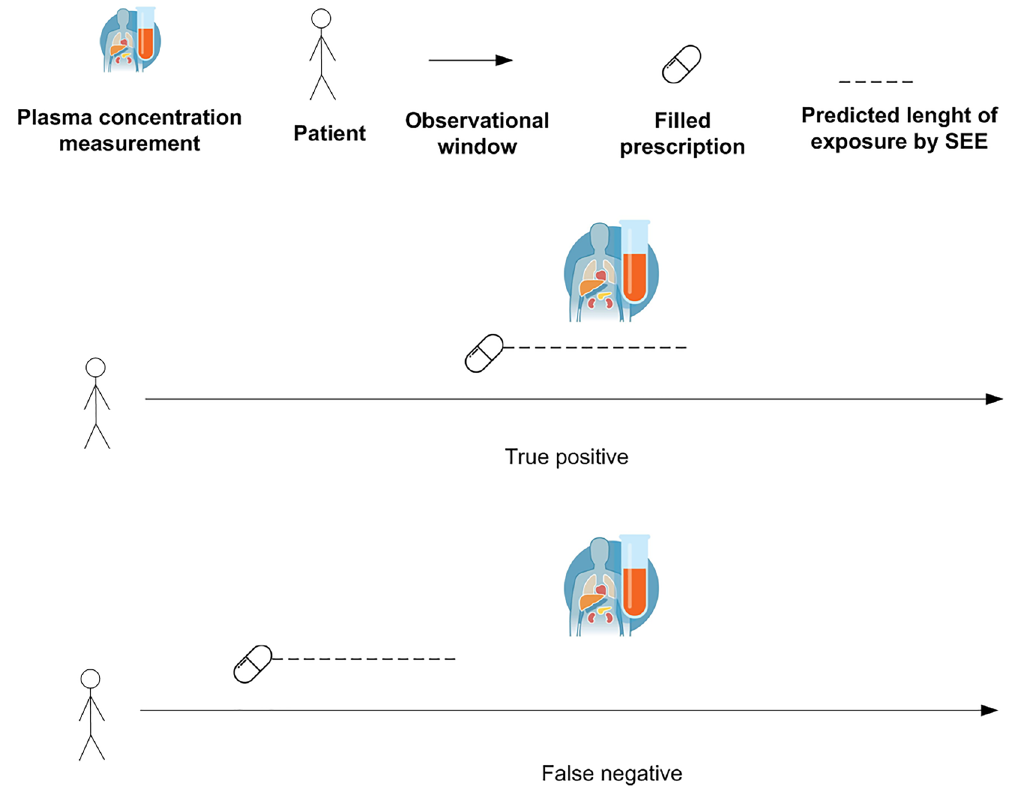
Figure 1. Evaluation of true positives and false negatives in real-world data. SEE = Sessa Empirical Estimator.